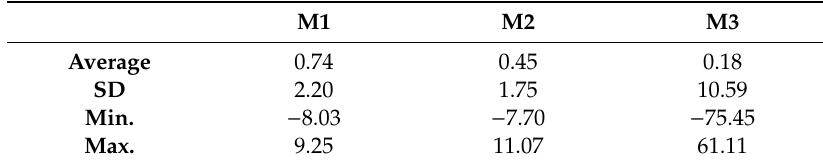
Table 4. Average manual refinements to the network calculations. M1, M2, and M3 = first, second, and third molar, respectively. Min. = minimum; Max. =